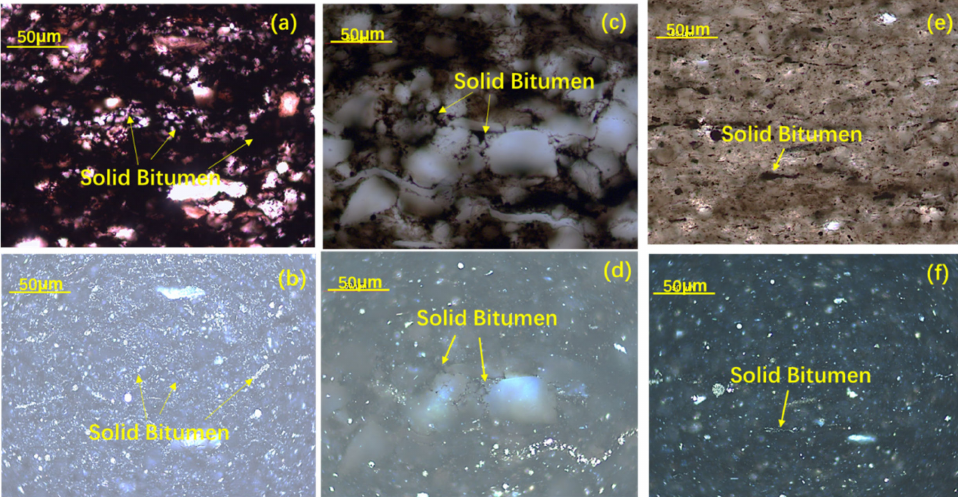
Figure 5. Micro-photos of solid bitumen (arrows). ( a – d ) Solid bitumen filled in the intergranular pore. ( e , f ) Solid bitumen filled in the micro-fractures along the bedding. ( a , c , e ) were micro-photos under transmitted polarized light; ( b , d , f ) were micro-photos under reflected light. Oil immersion, × 500. Scale bar = 50 µ